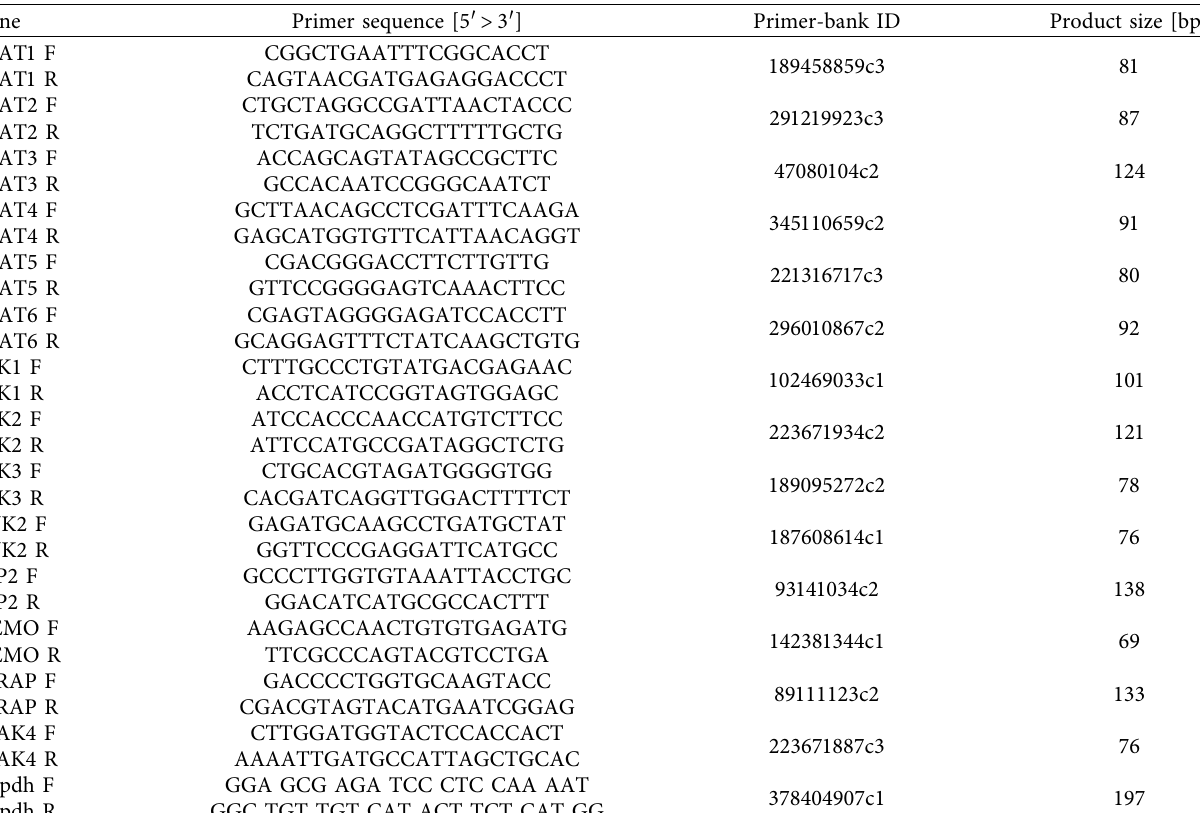
Table 1: Primer sequences used in this